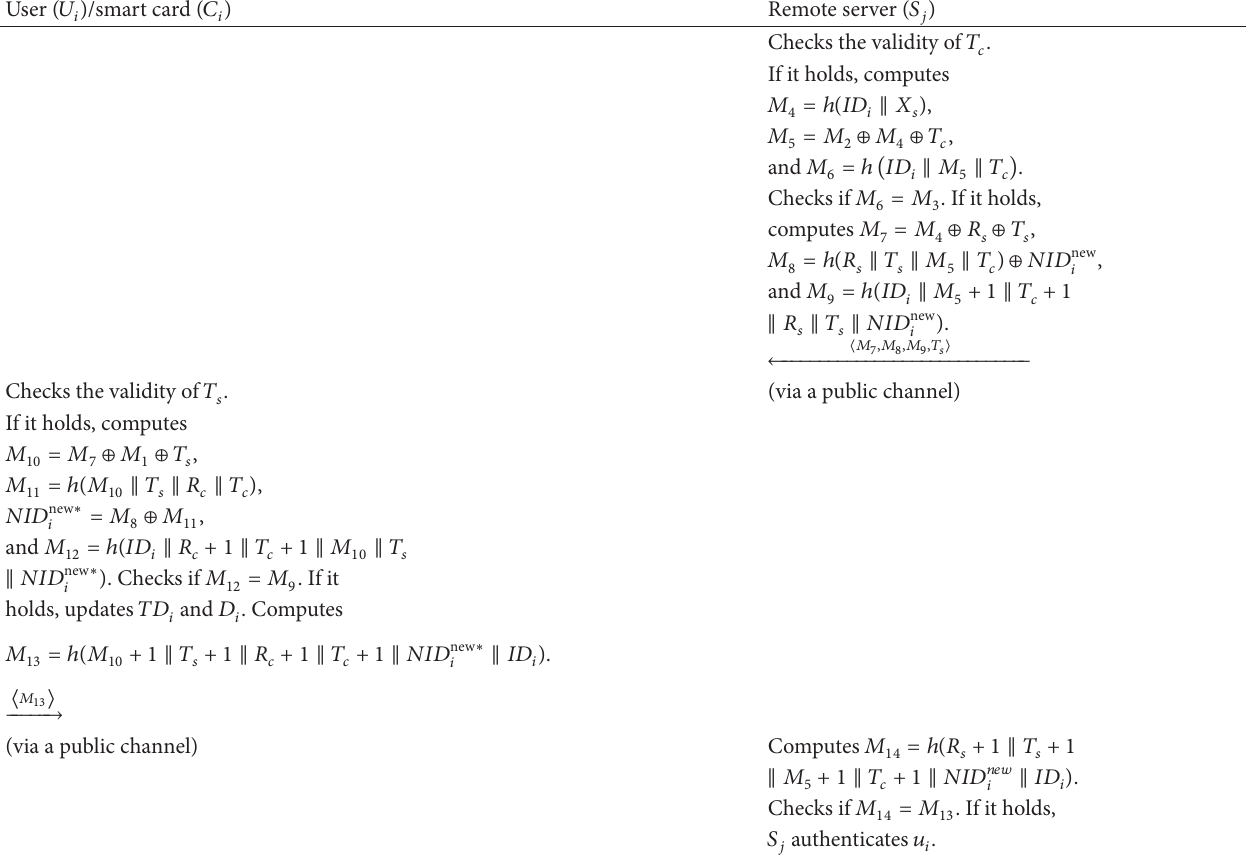
Table 3: Summary of the authentication phase of our